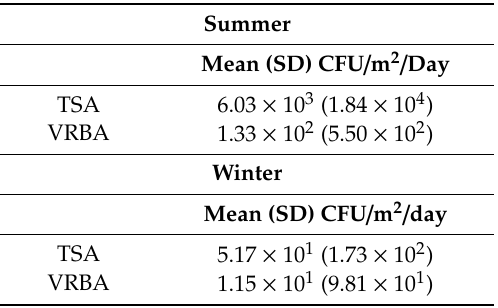
Table 5. Distribution of bacterial contamination on Electrostatic Dust Collector (EDC).